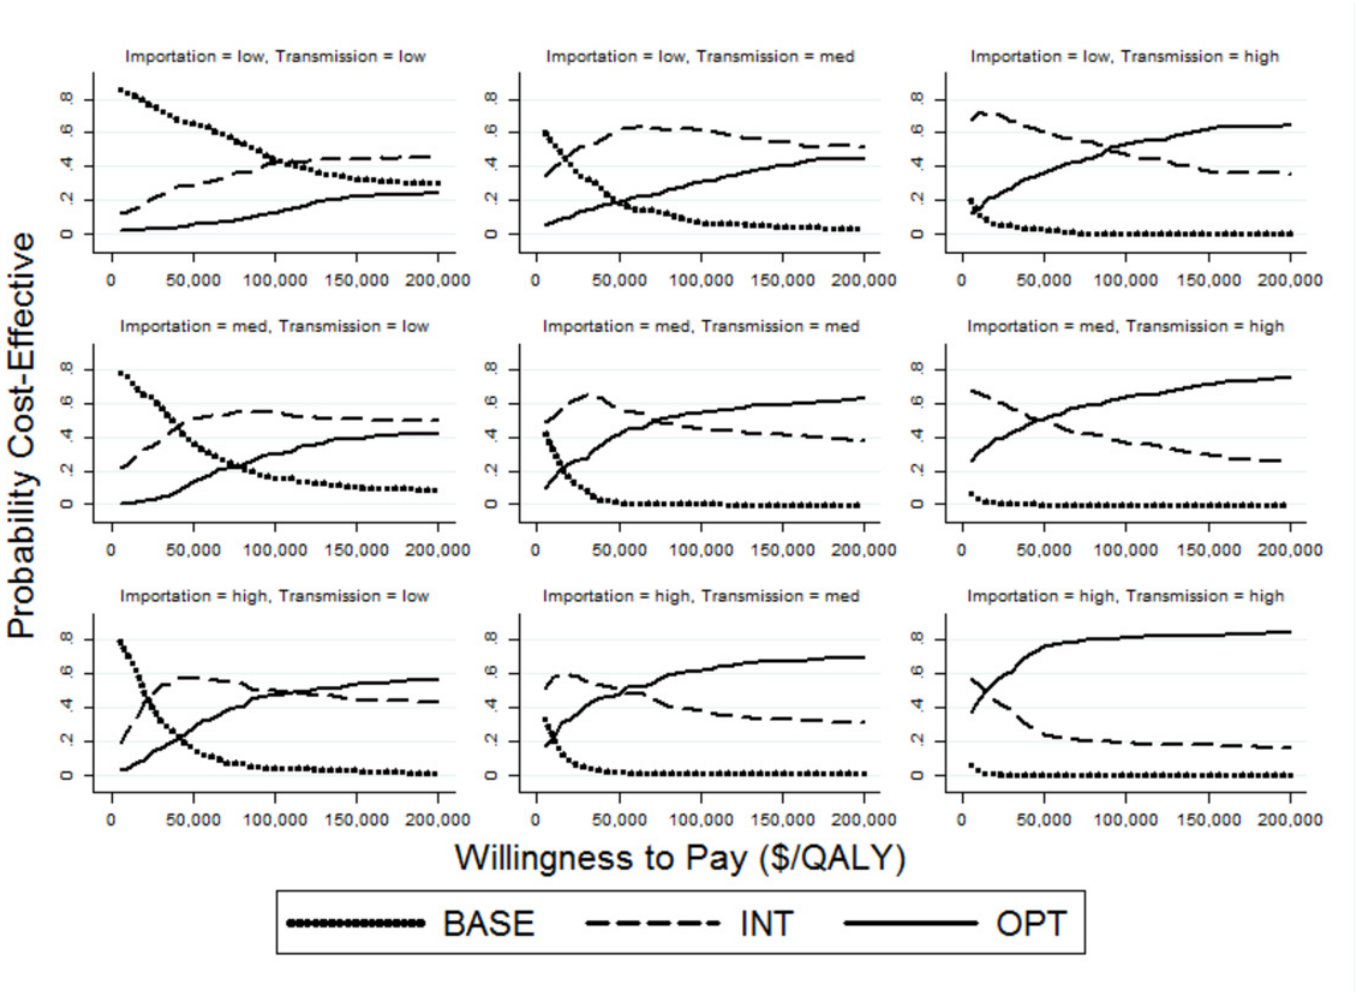
Fig 3. Cost-effectiveness acceptability curves depicting the probability that BASE, INT, and OPT strategies are cost-effective across different threshold values of willingness to pay from 195 2 nd order Monte Carlo simulations.